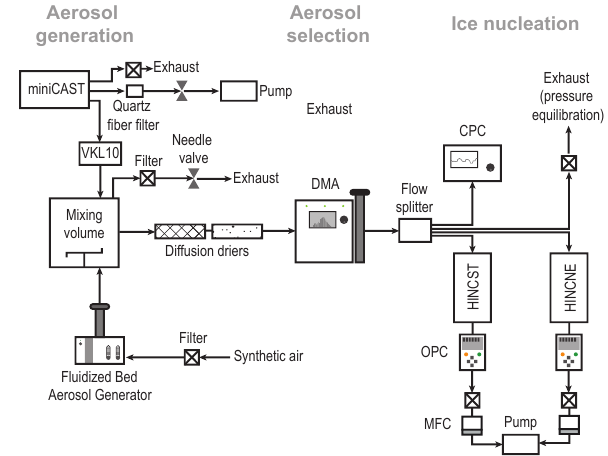
Figure 1. Schematic of the experimental setup comprising three dif- ferent stages: aerosol generation, aerosol size selection and ice nu- cleation measurements. Arrows indicate the direction of the aerosol flow. Aerosol particles were either produced by the miniCAST burner or generated from the FBG. See text for details and abbrevi-